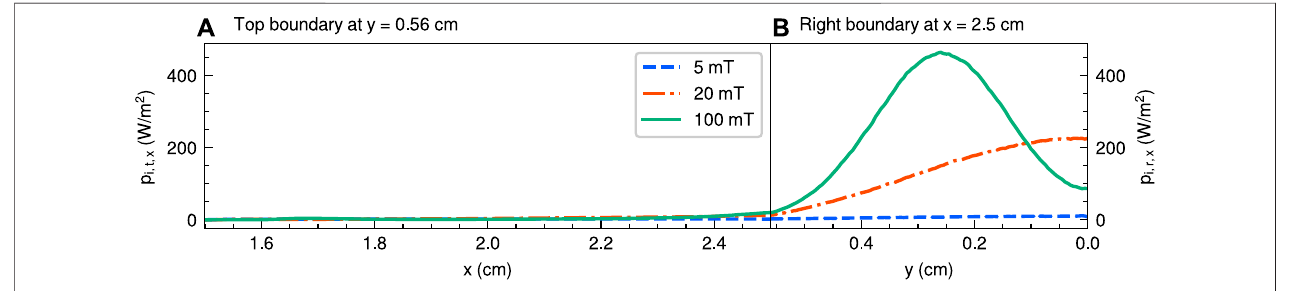
FIGURE 8 | (A) x and (B) y pro fi les of the ion energy fl uxes in the x -direction on the top boundary ( y (cid:1) 0.56 cm) p i , t , x and the right boundary ( x (cid:1) 2.5 cm) p i , r , x , respectively, for the three magnetic fi eld strengths of 5(a dashed blue line), 20(a dotted-dashed orange line), and 100 mT (a solid green line). Note that x (cid:1) 2.5 cmin (A) corresponds to y (cid:1) 0.56 cm in (B)